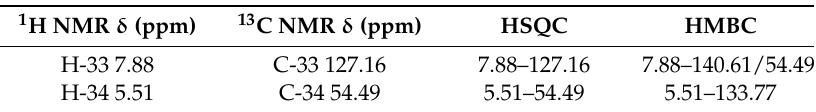
Table 1. The selected chemical shifts 1 H NMR and 13 C NMR and correlations proton–carbon (HSQC and HMBC experiments) for compound 5a .